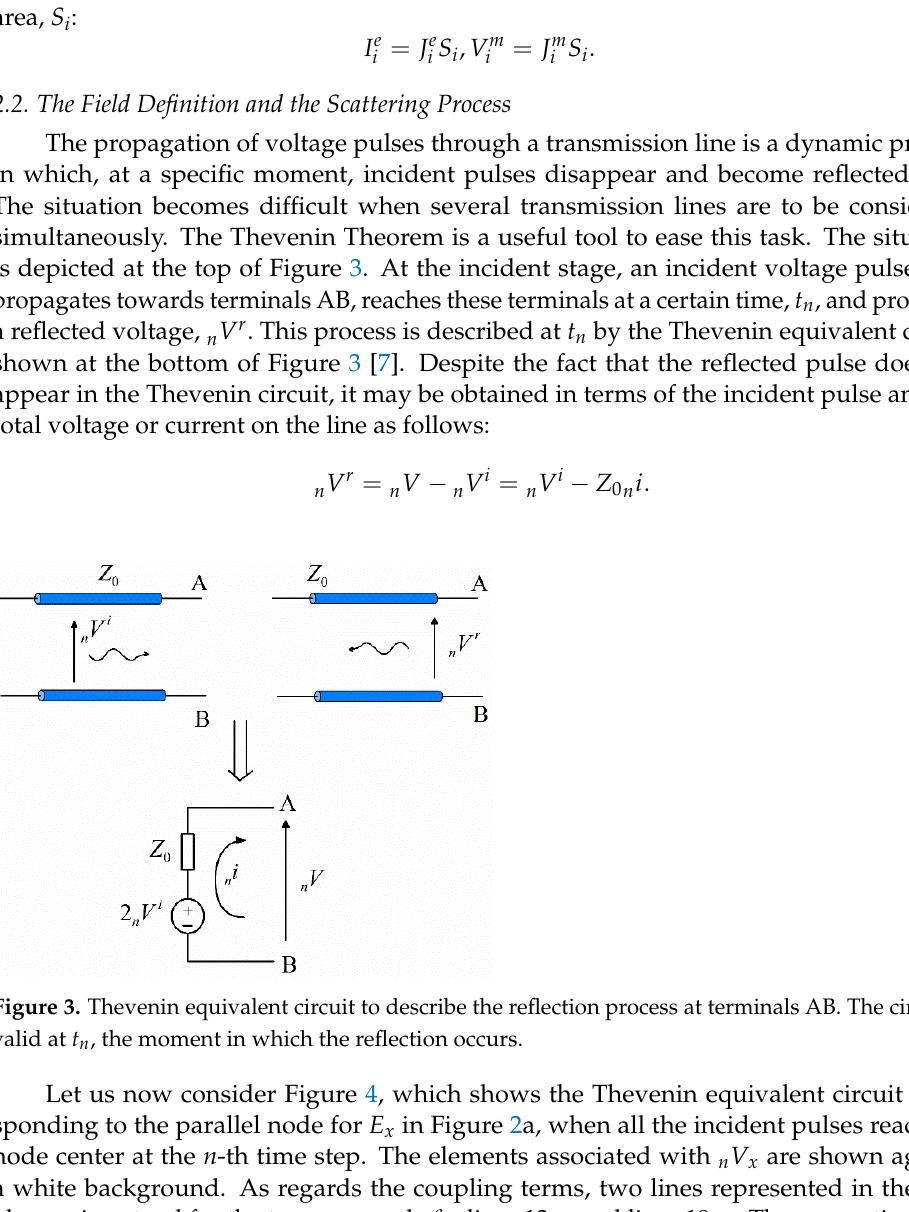
Figure 4. Thevenin equivalent circuit of the shunt node for E x at time t n . Green boxes denote a formal connection, allowing for the voltage at the upper terminals to be n V x for the link lines, the source, and lines 13 xx and 19 xx ¸while the voltage is n V y for lines 13 xy and 19 xy (in the pale blue region) and n V z for lines 13 xz and 19 xz (in the pale red region). The current flowing through line 1 is given by the following equation: (